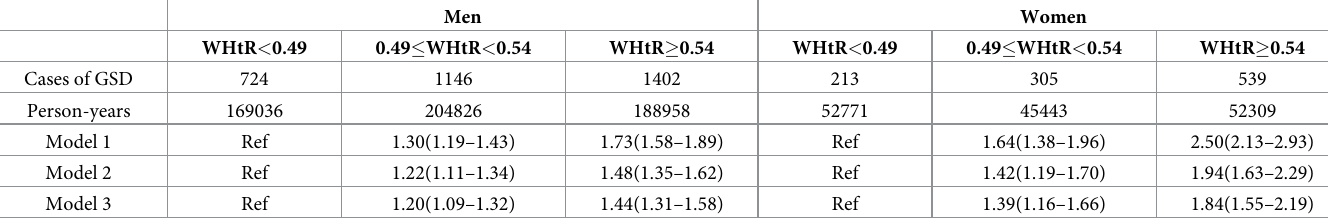
Table 4. Hazard ratios (HRs) and 95% confidence interval(CI) for risk of new onset gallstones disease according to WHtR tertiles.